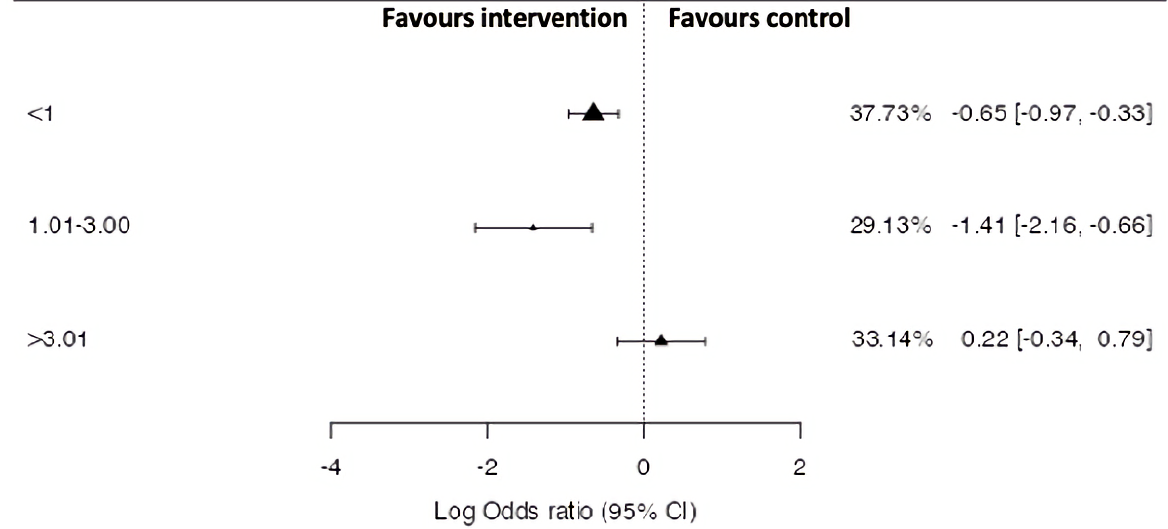
Figure 3. Comparison of average weeks per exposure on hamstring strain injury risk odds ratios based on grouped study estimates, 95% CI and WMD%.